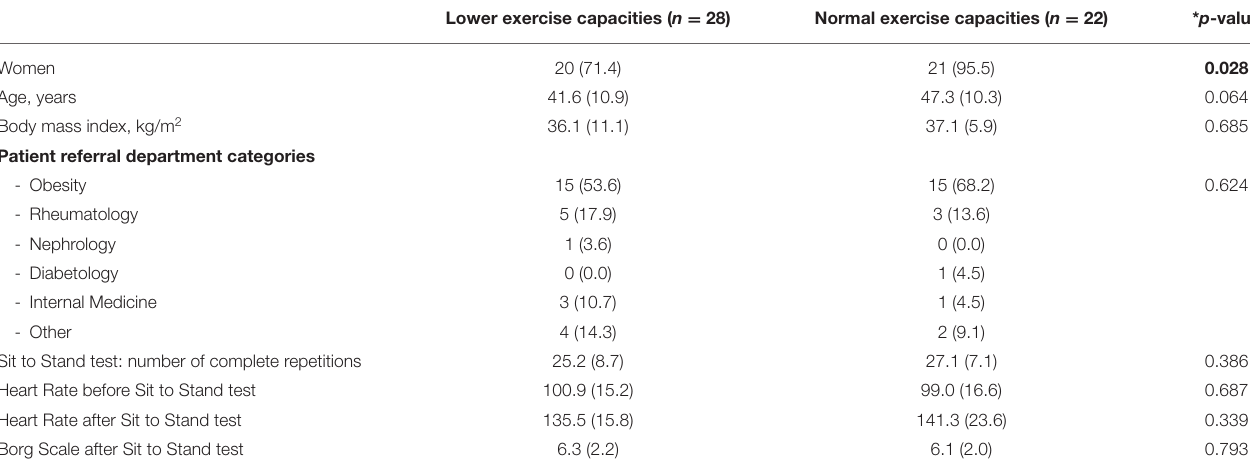
TABLE 1 | Baseline demographic and clinical characteristics ( n =